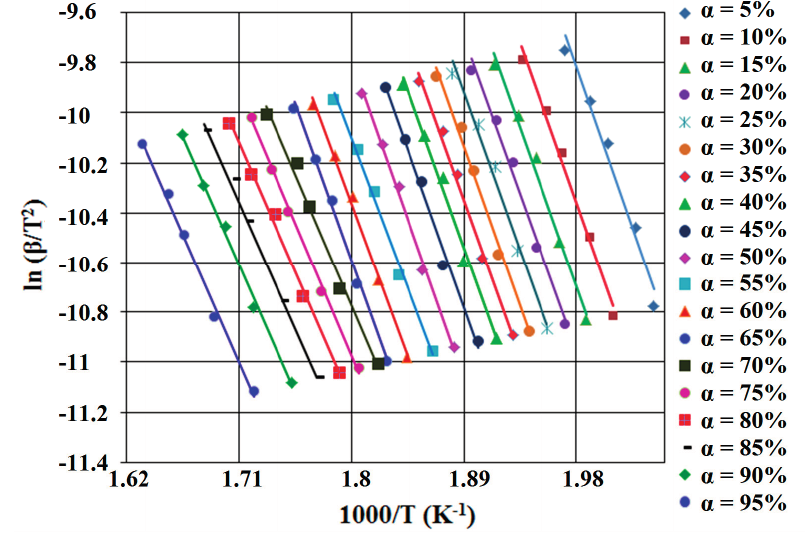
Figure 9. KAS diagram, for SB2